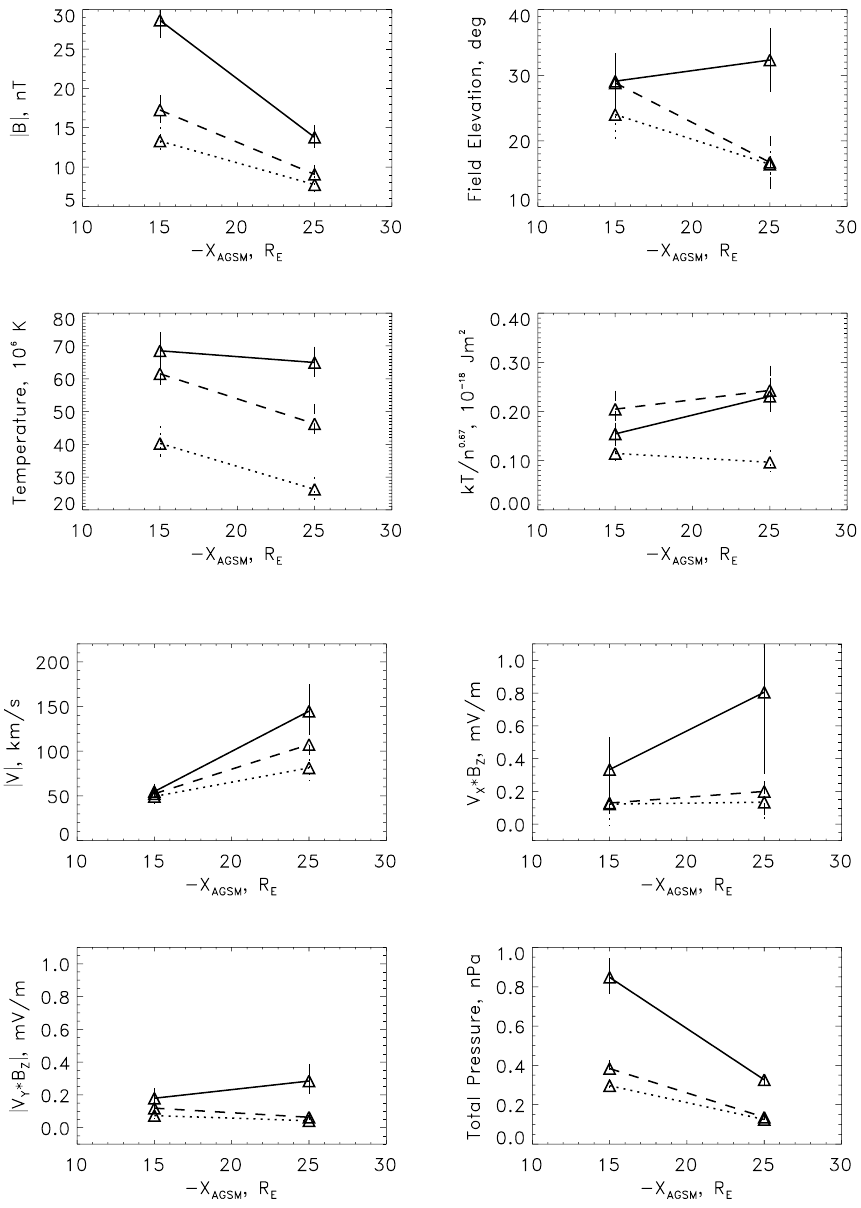
Fig. 1. Average values of the magnetic field strength, of the magnetic field el- evation, of the total (i.e. thermal and magnetic) pressure, and of the ion spe- cific entropy in the central plasma sheet. Solid lines: main phase, dashed: recov- ery phase, dotted: quiet times (D st > − 25 ) . Error bars are 0.2 σ of the data distribution functions.